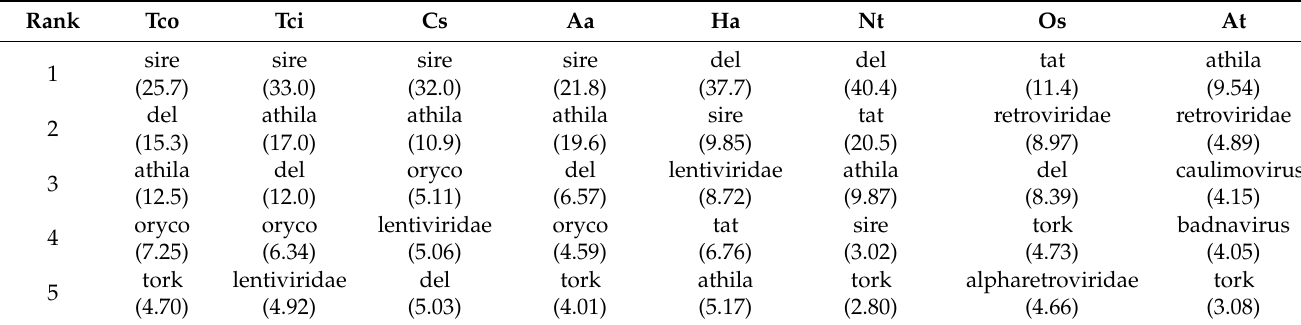
Table 4. Annotation statistics for the draft genome.